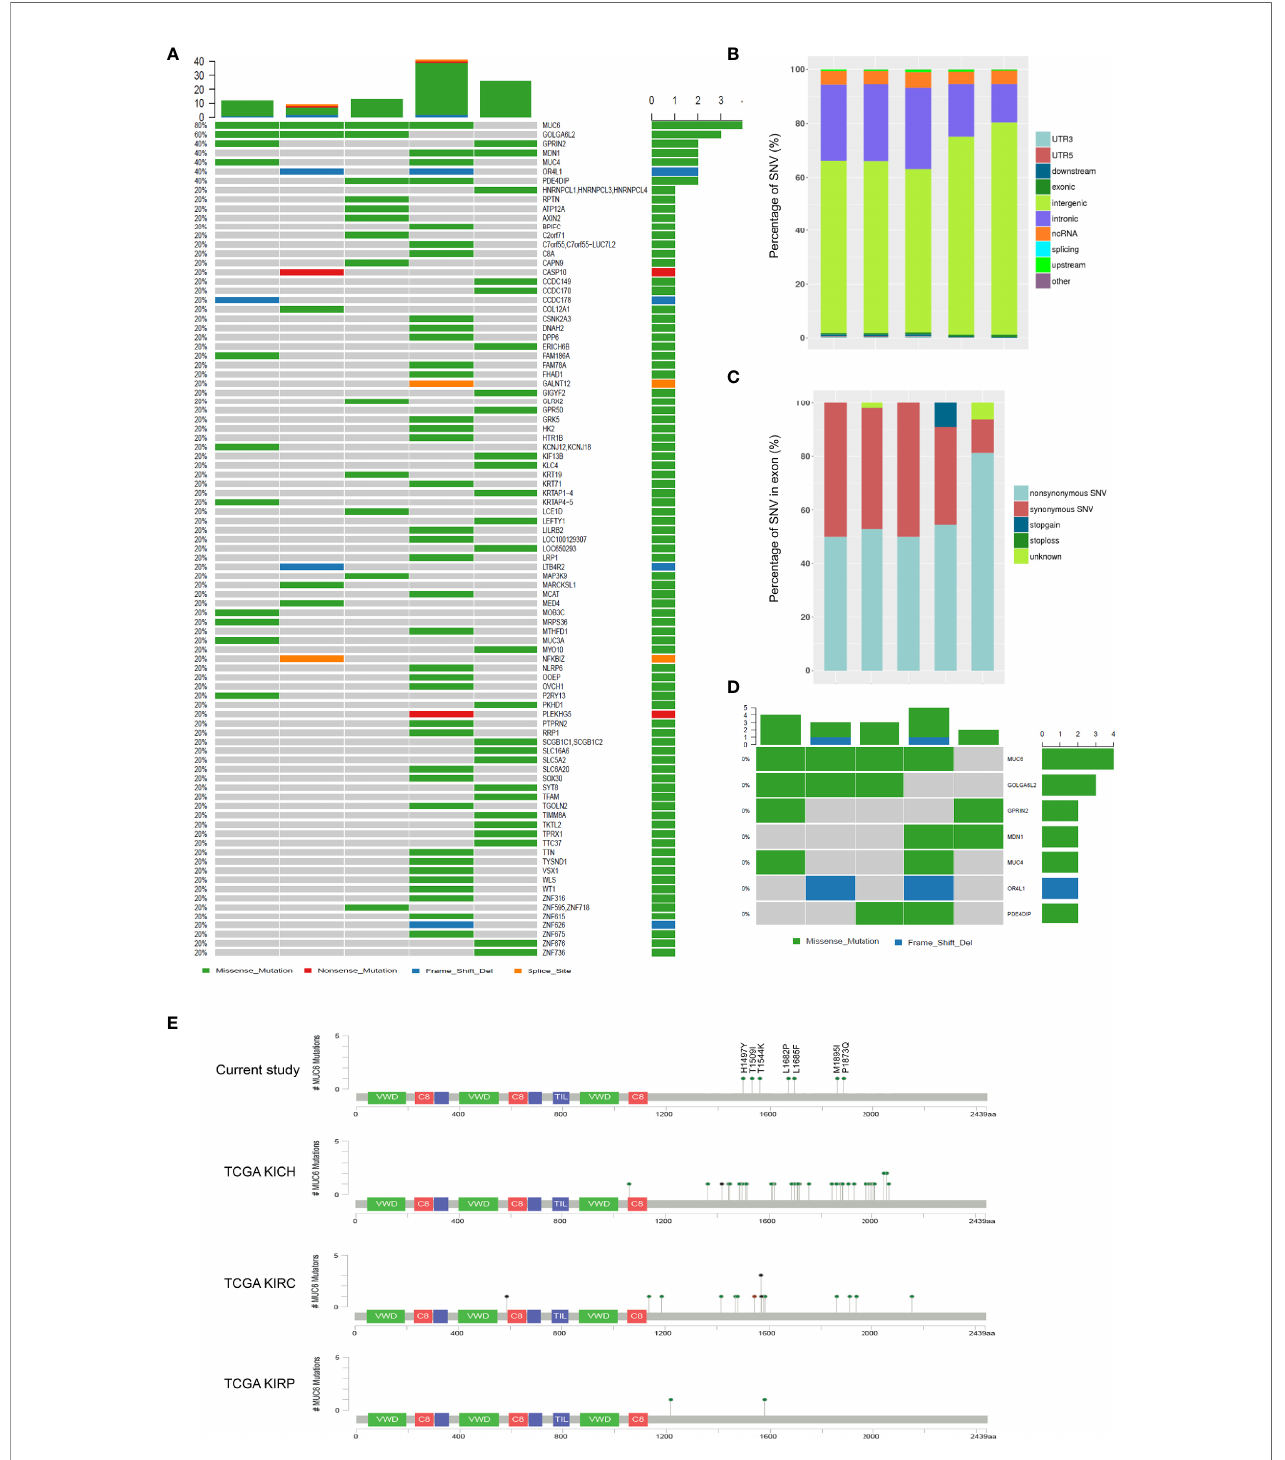
FIGURE 1 | Whole genome sequencing of WT samples. (A) SNVs in 5 fresh-frozen WT samples. The colored squares refer to the corresponding types of SNVs (missense, nonsense, frame shift indel and splice site). (B) The genomic distribution of all SNVs. (C) The functional category of all SNVs in exon. (D) SNVs in 7 genes which were mutated twice or more. (E) Schematic representation of human MUC6 protein, showing the positions of 7 identi fi ed mutations in current study and MUC6 mutations in TCGA KICH, KIRC and KIRP